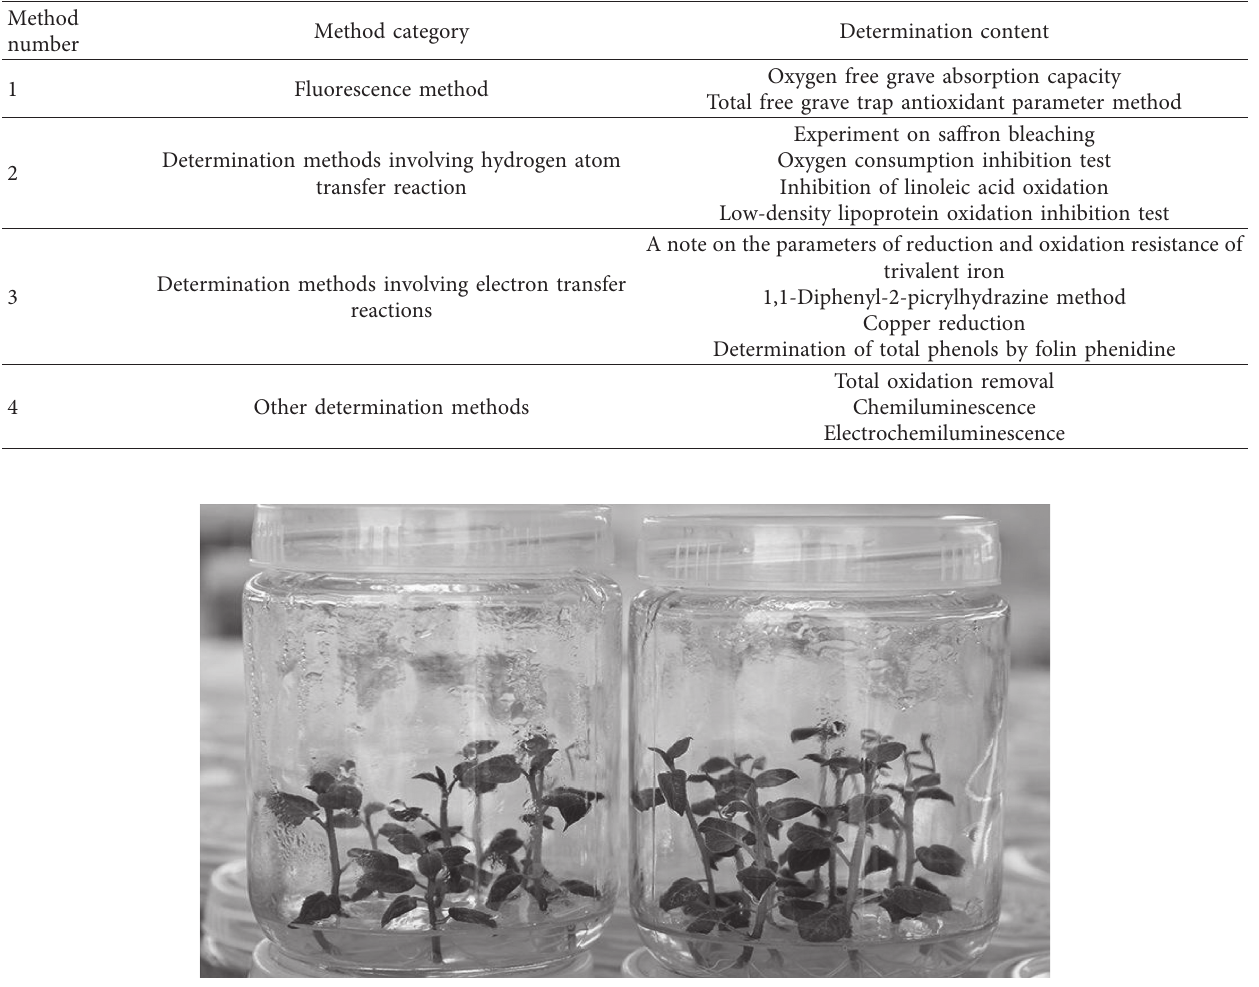
Table 1: Determination of antioxidant activity in vitro.